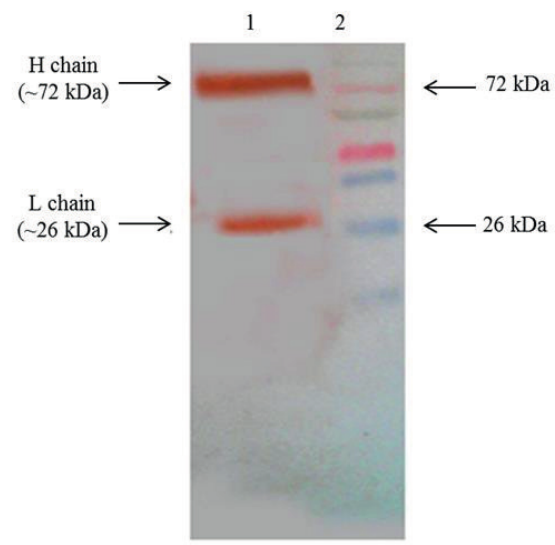
Figure 2 - Western blot analysis of rabbit anti-pacu IgM hy- perimmune serum. Pacu total serum (lane 1) and molecular weight marker (lane